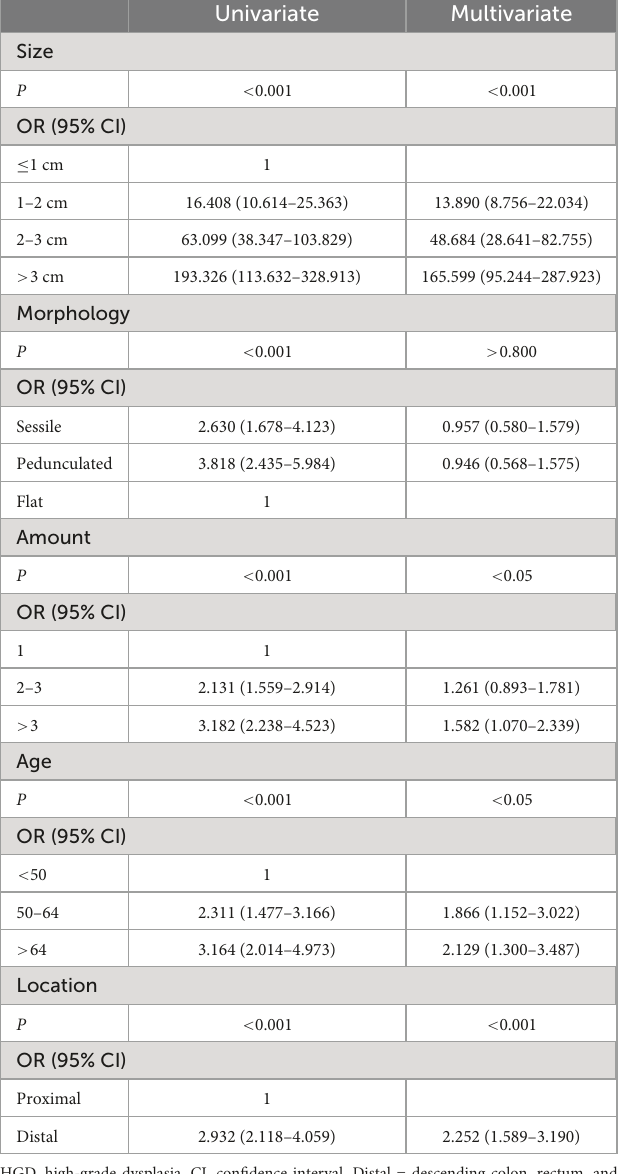
TABLE 4 Comparison of univariate and multivariate analysis of adenoma TABLE 5 Age distribution of adenoma location, amount, size, and factors relative to the occurrence of HGD. Univariate Multivariate